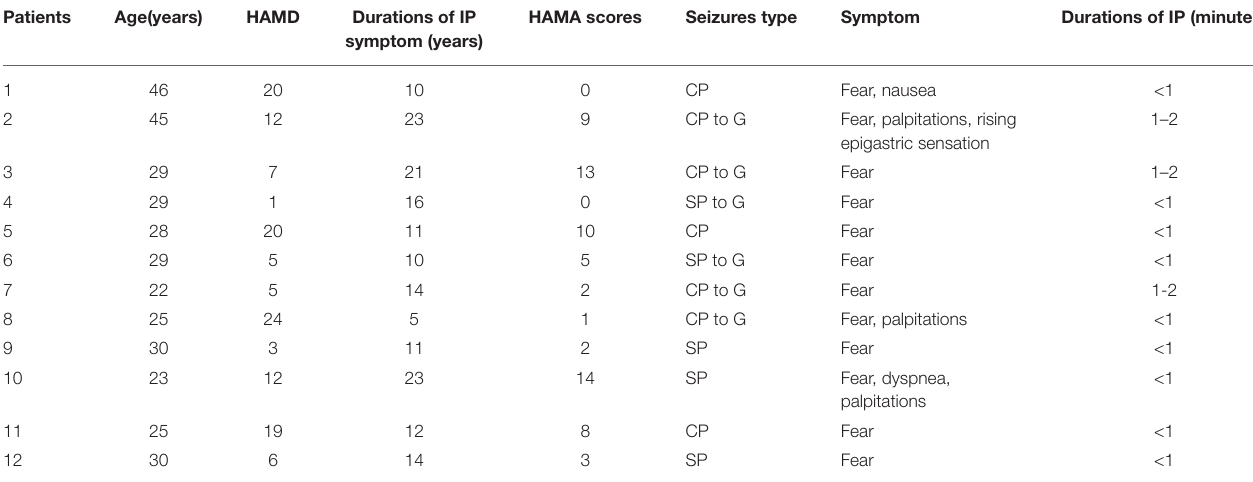
TABLE 2 | Temporal lobe epileptic ictal panic (TLEIP) characteristics.